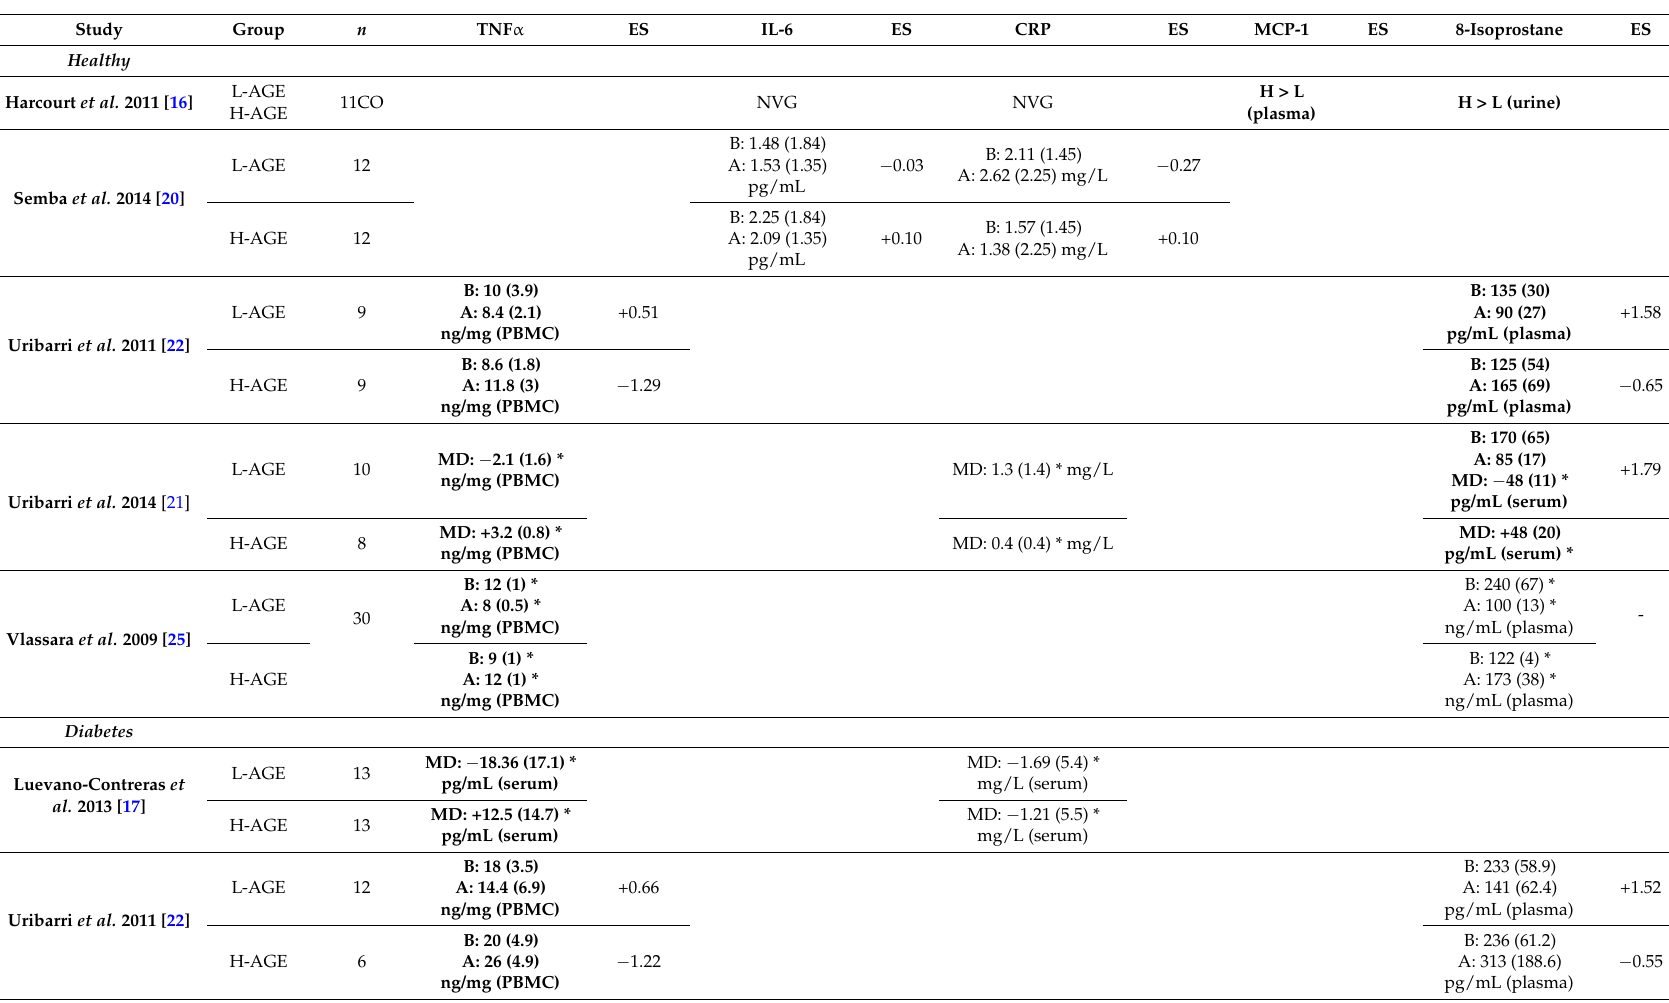
Table 2. Circulating biomarkers of inflammation and oxidative